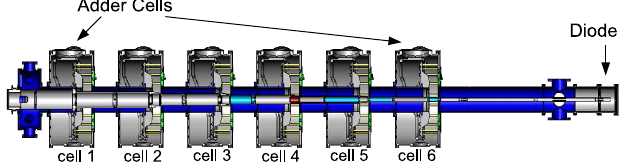
FIG. 1. (Color) Cross section of the RITS-6 induction cell cavities and the